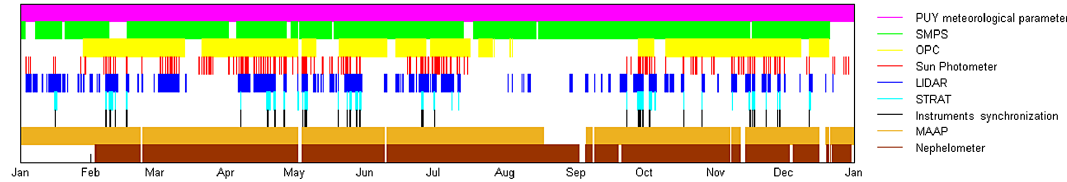
Figure 3. Temporal series of available instruments and cloud screening from RH information during the year 2011. Magenta, green, yellow, red, blue, orange and brown areas represent meteorological parameters at PUY station, SMPS, OPC-GRIMM, sun photometer, lidar, MAAP and nephelometer date. The cyan area shows STRAT selection from lidar analysis and the black area gives selected points for this study.